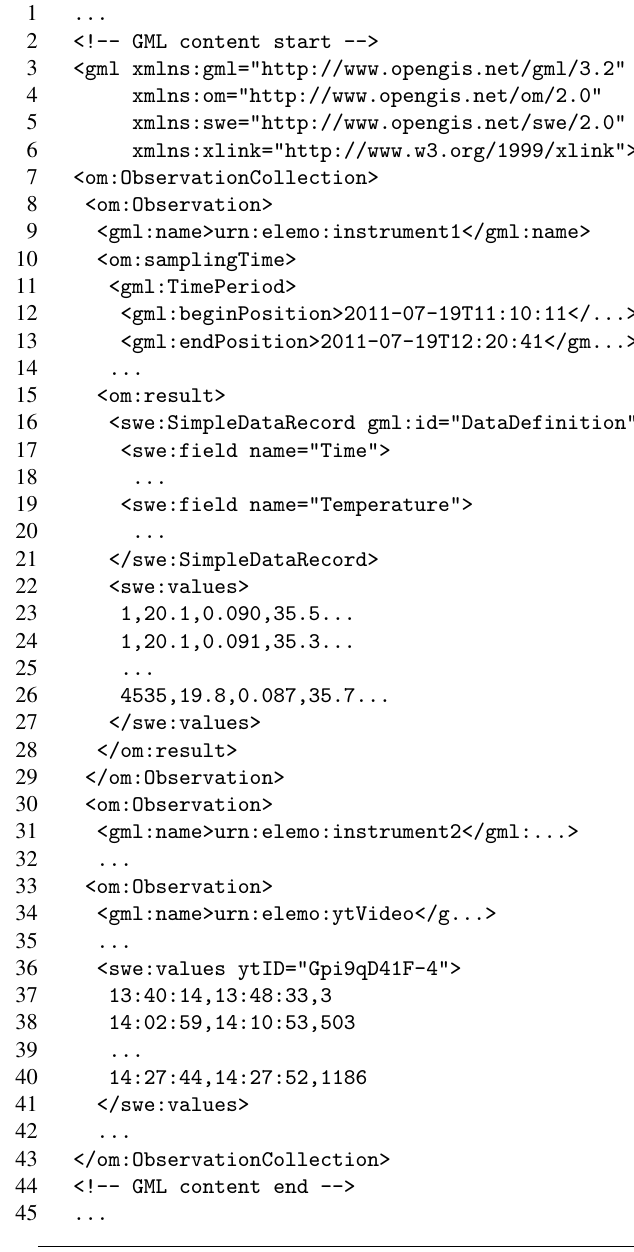
Table 1: Description of a single day collected in the course of ´El´emo field campaign and encoded using a combined OGC KML (2008)/GML (2012) format as suggested by Lake (2007). The cor- responding GML content is detailed in Table 2.